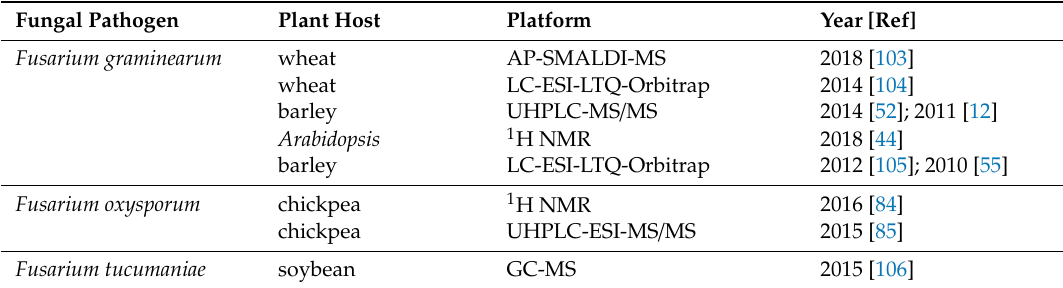
Table 2. Recent metabolomics studies in fungal pathogen–plant interactions. Fungal